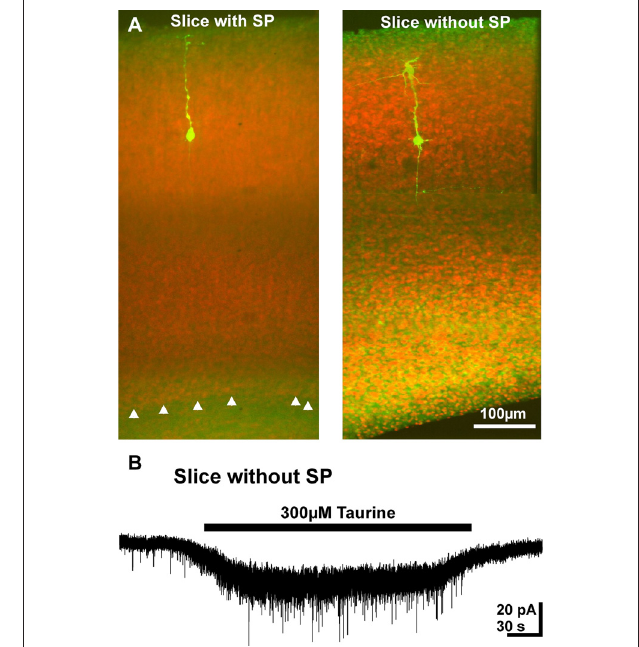
FIGURE 9 | Taurine effect on pyramidal neurons in reduced slice preparation . (A) Confocal images of biocytin-labeled neurons (green) counter-stained with propidium jodide. Note the absence of the SP (white arrowheads) in the right slice. (B) Typical current registration illustrating that bath application of taurine increased the frequency of PSCs in a reduced slice preparation without